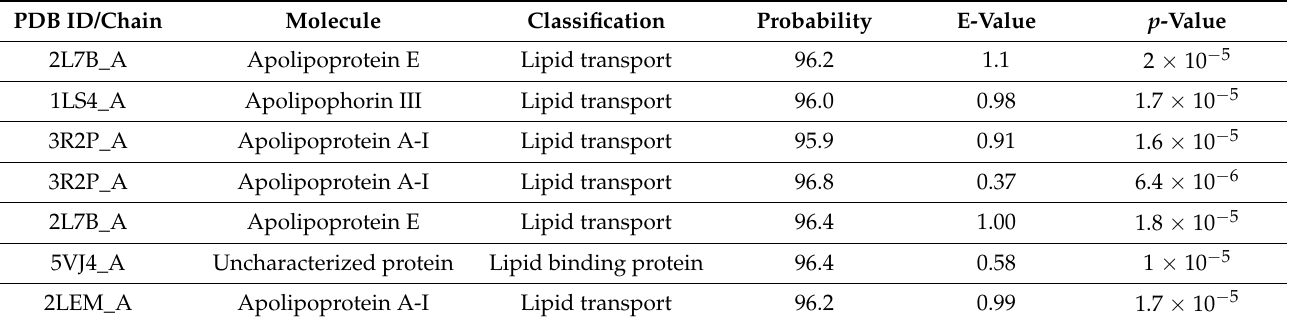
Table 2. Selected homologous templates for subunit III